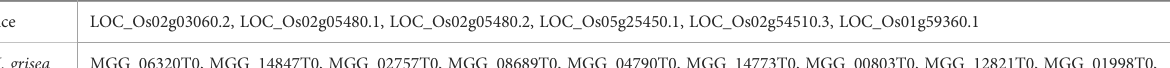
TABLE 2 List of potential rice and M. grisea protein participating in multiple interactions.